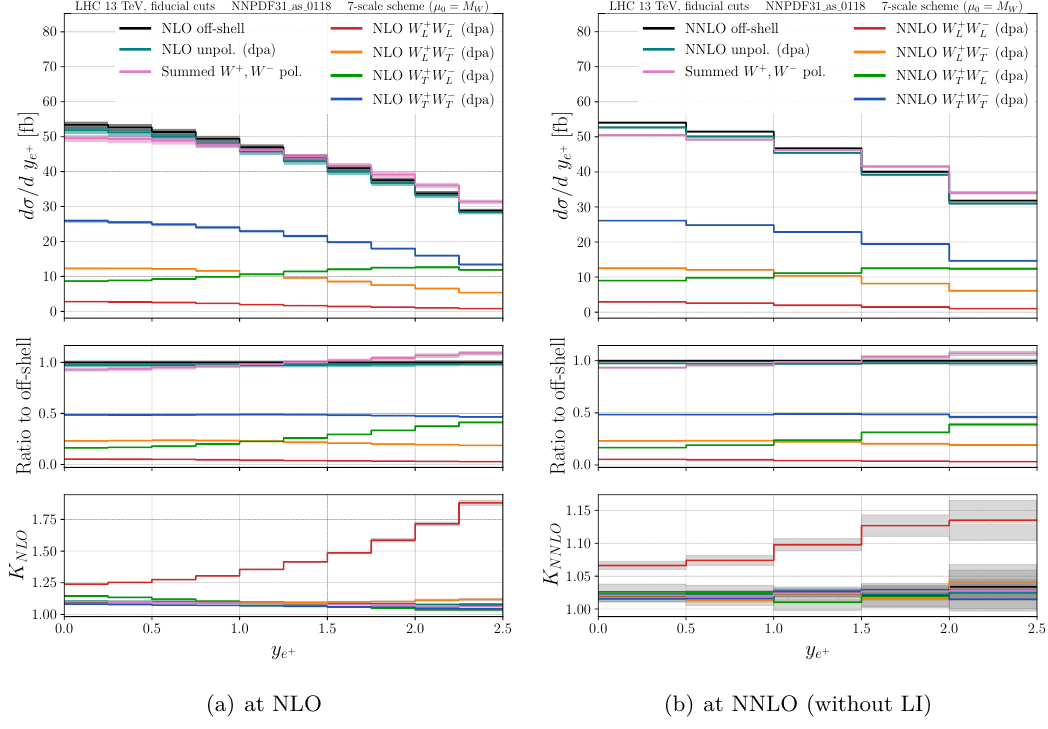
Figure 4 . Symmetrised distribution of e + rapidity at different orders of QCD. Doubly-polarised setups are shown. Individual plot substructure is the same as in figure